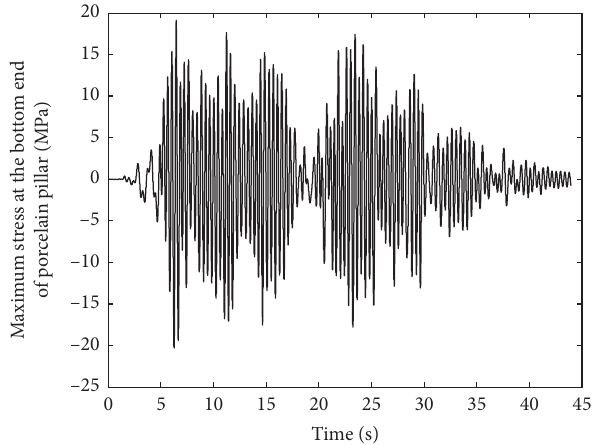
Figure 23: Maximum stress at the bottom of porcelain pillar ( a � 0.3 g, η � 20,000).